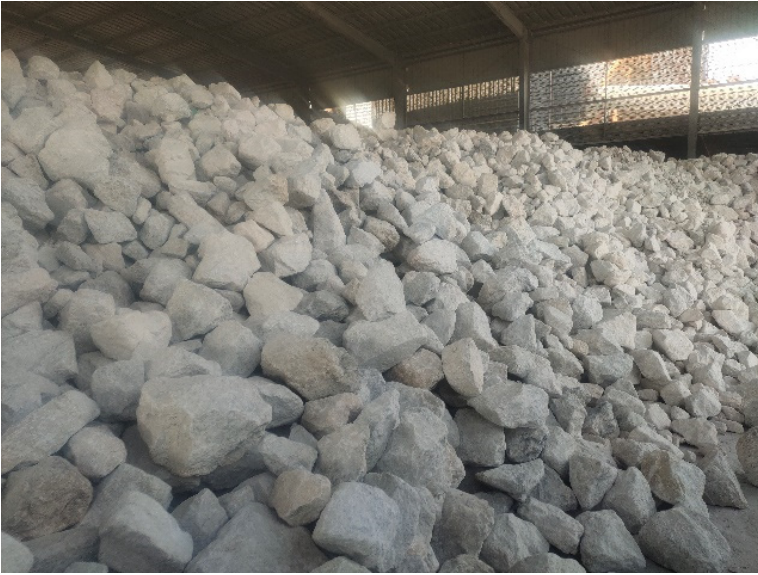
Figure 2. Furnace charged for smelting. Table 2. Reduction reaction.